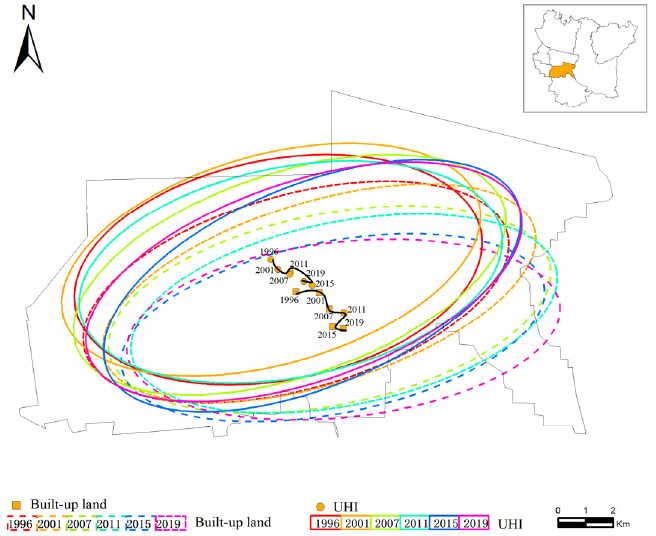
Figure 9. Evolution of center points and standard deviation ellipse (SDE) of the built-up land and urban heat island (UHI) of Yuhua District from 1996 to 2019.